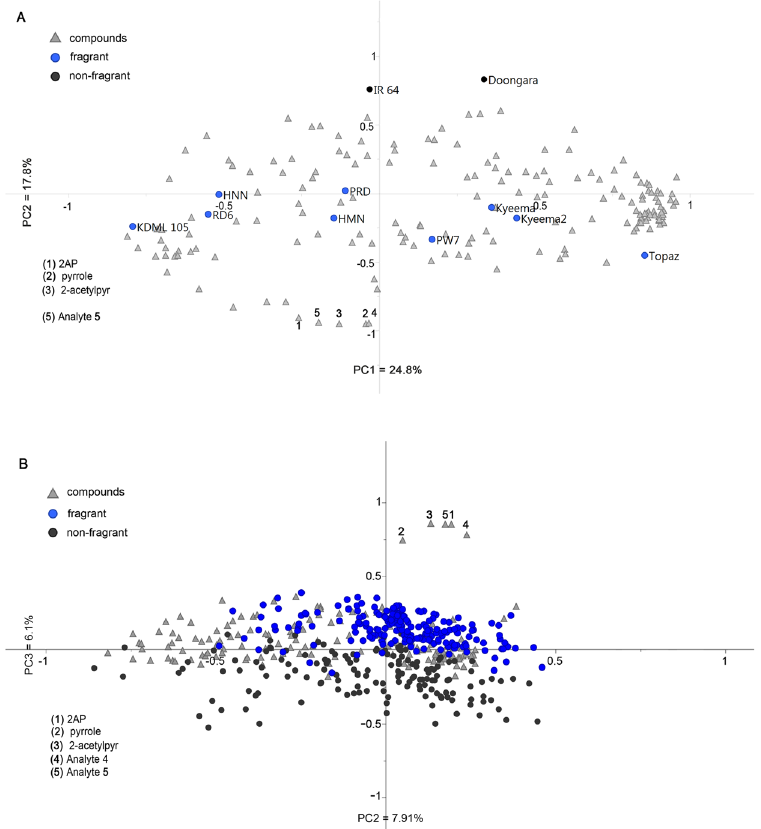
Figure 1. PCA biplot of the volatile metabolites detected in rice by GC × GC-TOF-MS. Metabolites are the triangles, overlayed with the rice varieties (circles). ( A ) Set 1 (n = 11), PC1 = 24.8% and PC2 = 17.8%. ( B ) Set 2 (n = 341) PC2 = 7.91% and PC3 =